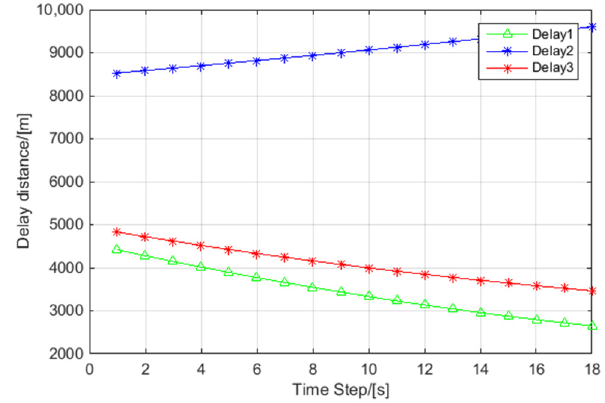
Figure 14. Delay distance of three UAVs.